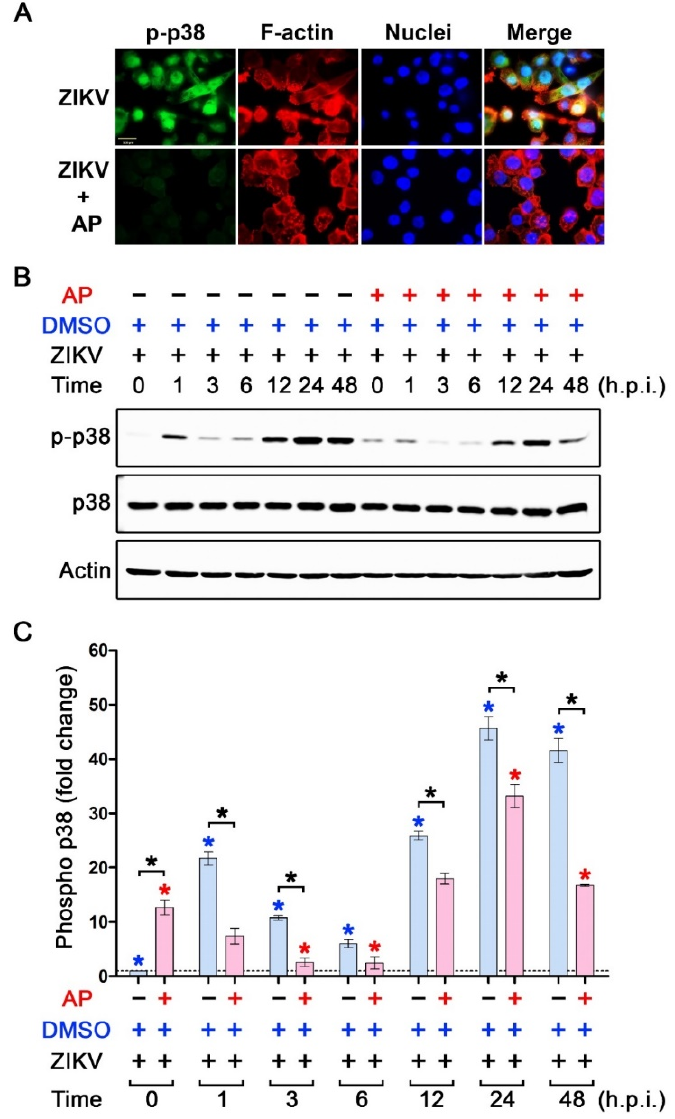
Figure 7. Effects of AP on the activation status of p38 kinase in ZIKV-infected THP-1 macrophages. ( A ) Immunofluorescence study detecting the presence of phosphorylated p38 kinase (p-p38) (green)